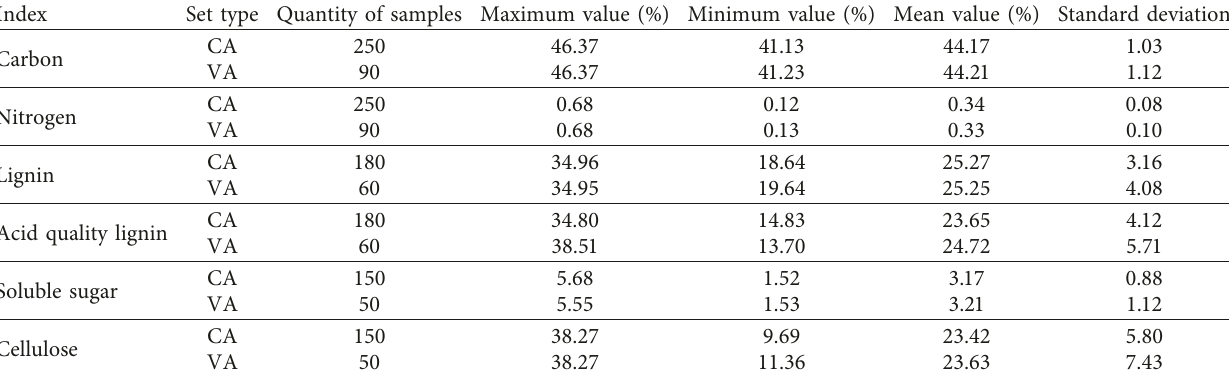
Table 2: Division of the calibration set and validation